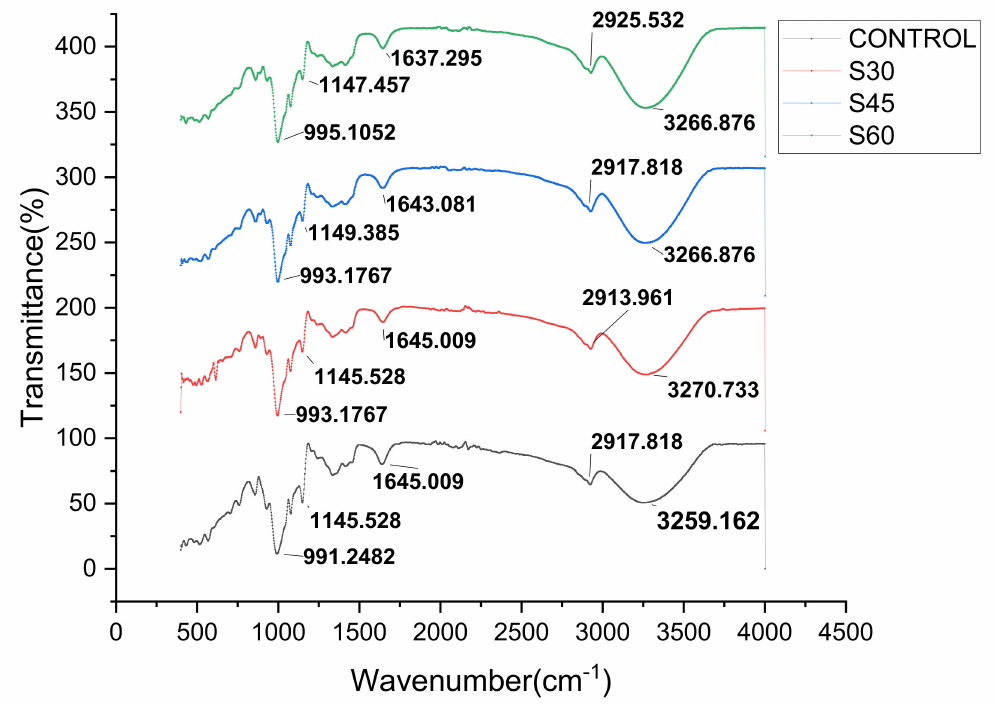
Figure 7. FTIR curves of CS films with various sorbitol